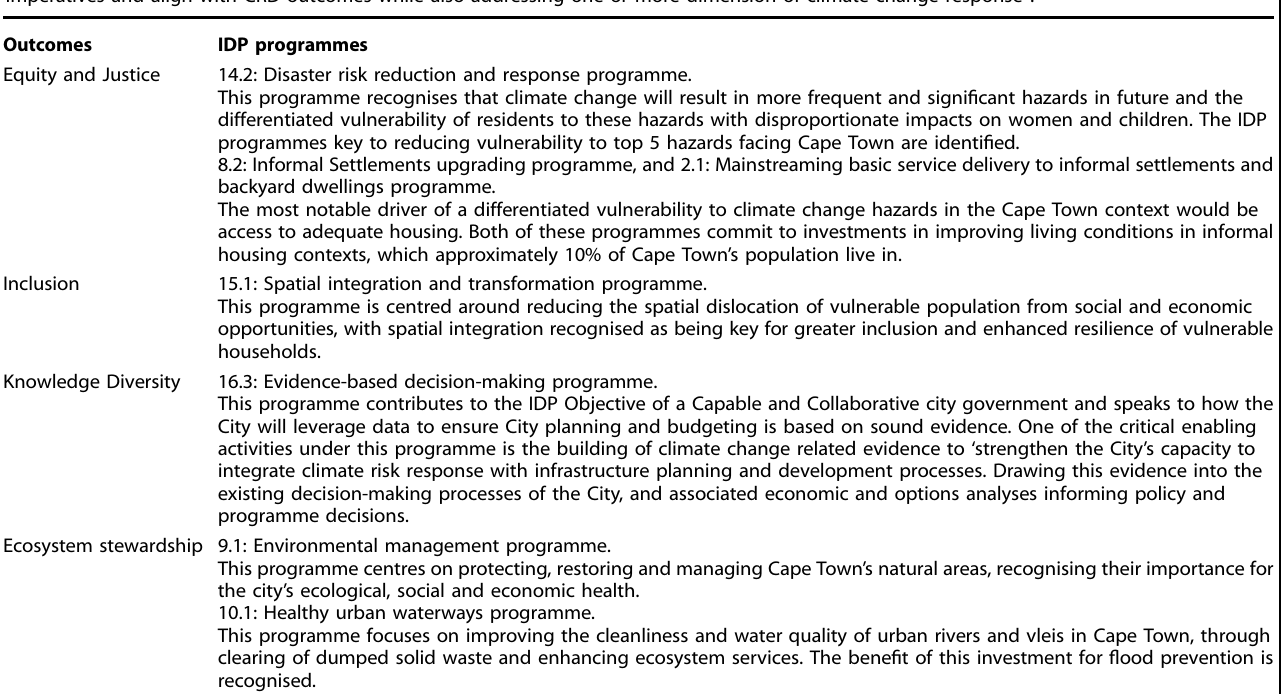
Table 2. Examples of programmes in the City of Cape Town ’ s Integrated Development Plan (2022 – 2027) which target key local developmental imperatives and align with CRD outcomes while also addressing one or more dimension of climate change response 5